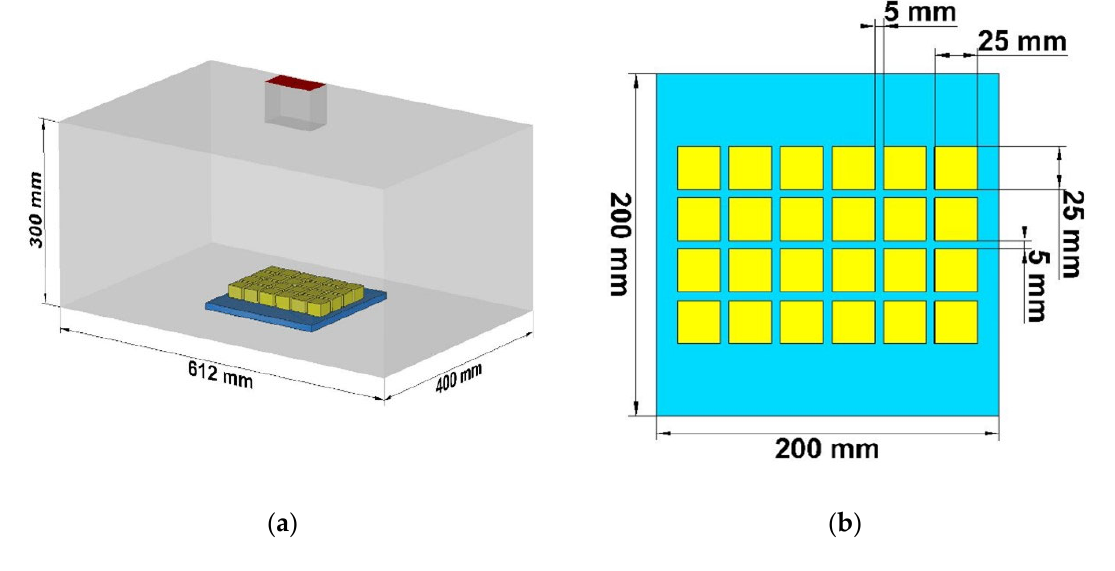
Figure 1. ( a ) Geometry of the process chamber in the electromagnetic simulations; ( b ) Geometry of the individual product samples and the product support in the electromagnetic simulations. Yellow—tylose gel; blue—product support made of PEEK; red—inlet waveguide. Table 1. Dielectric properties of the materials in the electromagnetic simulations.